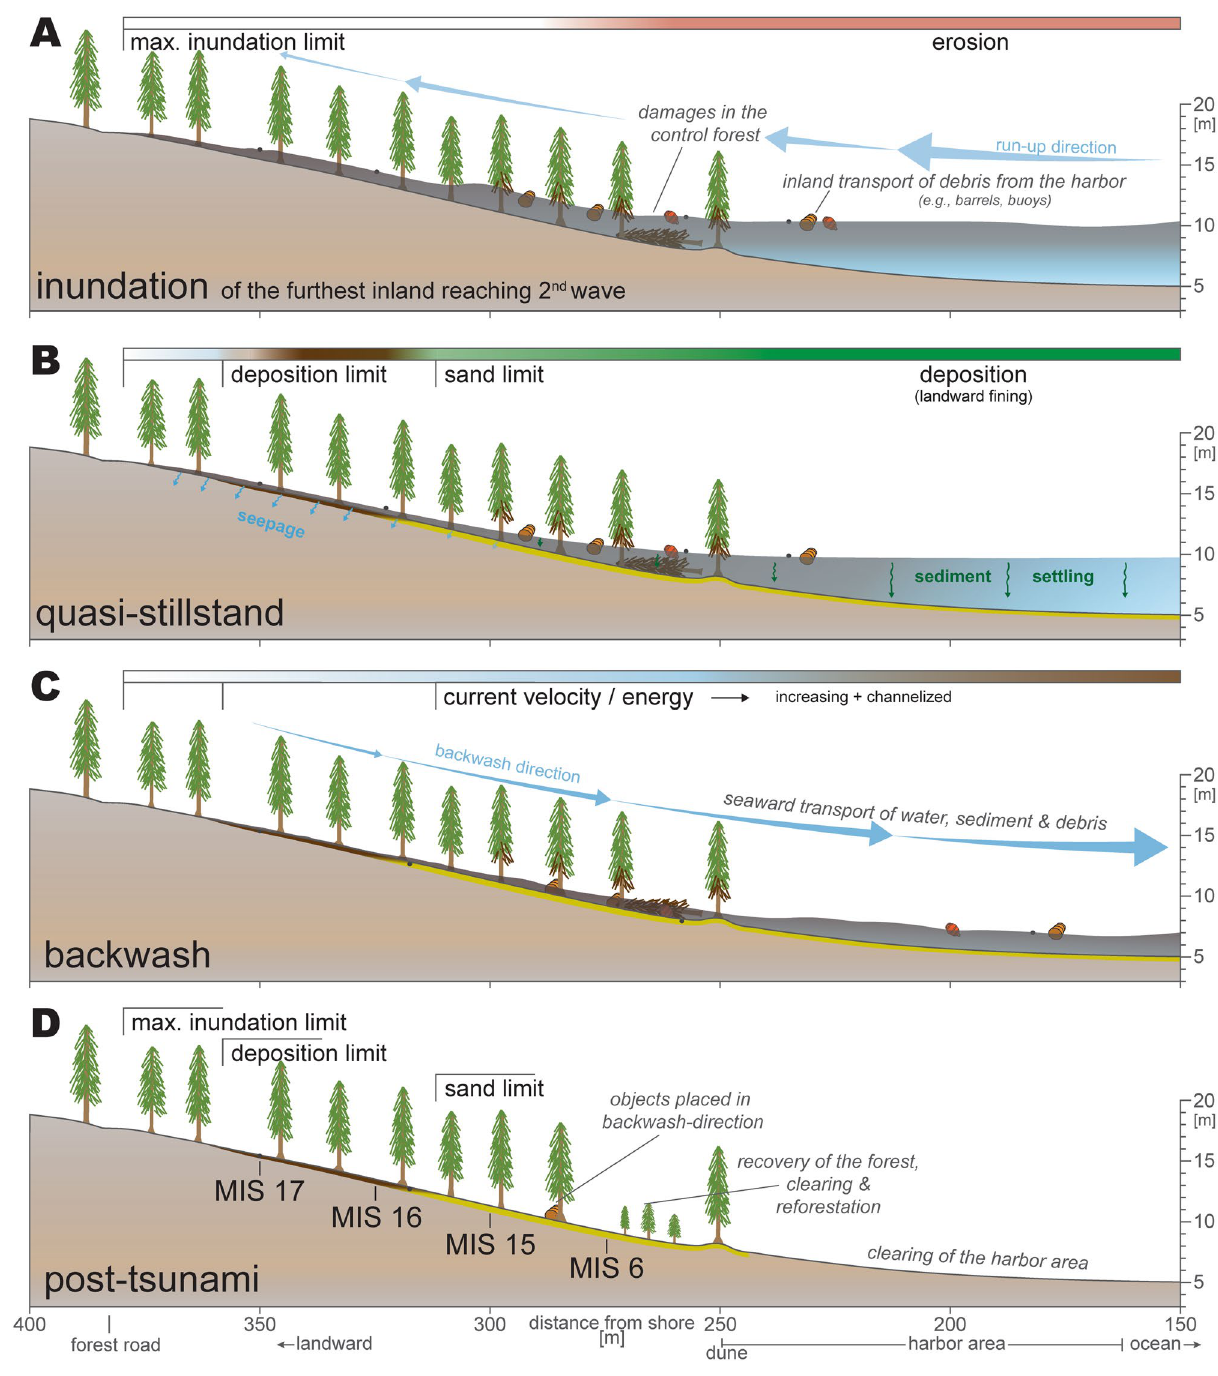
Figure 6. Conceptual model of erosion, transport and deposition of the sandy and organic-woody tsunami deposits during the 2011 Tohoku-oki tsunami at the Misawa harbor. ( A ) Inundation and erosion within the forest; ( B ) quasi-stillstand with settling and deposition of eroded material; ( C ) downslope increasing backwash with increasing erosion-potential and channelization; ( D ) post-tsunami setting and coring sites exemplary on transect T8. The conceptual model has been illustrated Adobe Illustrator (Creative Cloud version 2020, https:// adobe. com/ produ cts/ illus